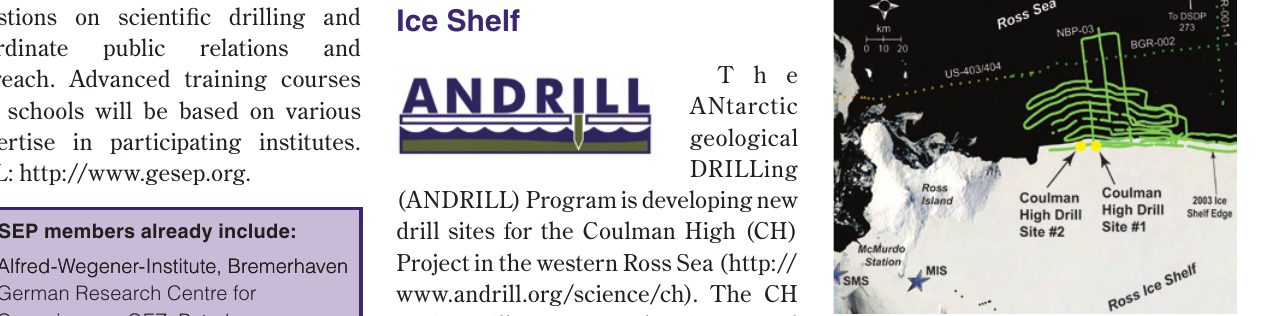
Fig. 1. Coulman High Drilling Project site location map. Proposed drill sites (yellow dots) are 125 km from McMurdo Station. Prior successful ANDR�LL drill sites SMS and M�S are shown